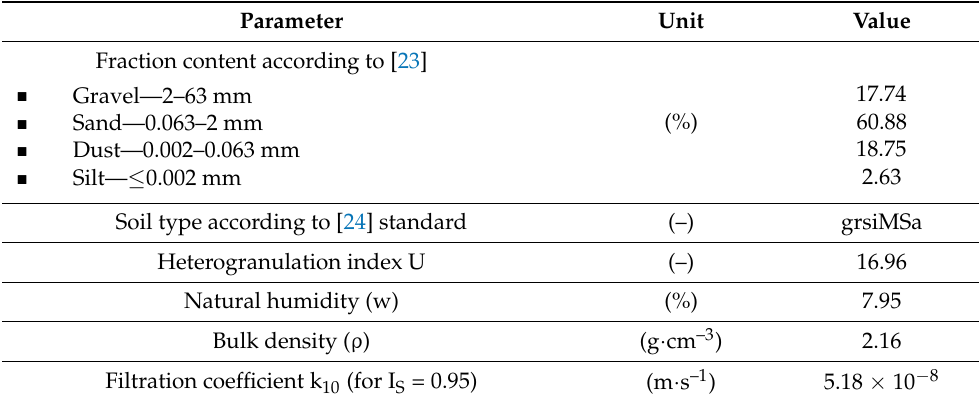
Table 2. Basic geotechnical parameters of the soil material. Parameter